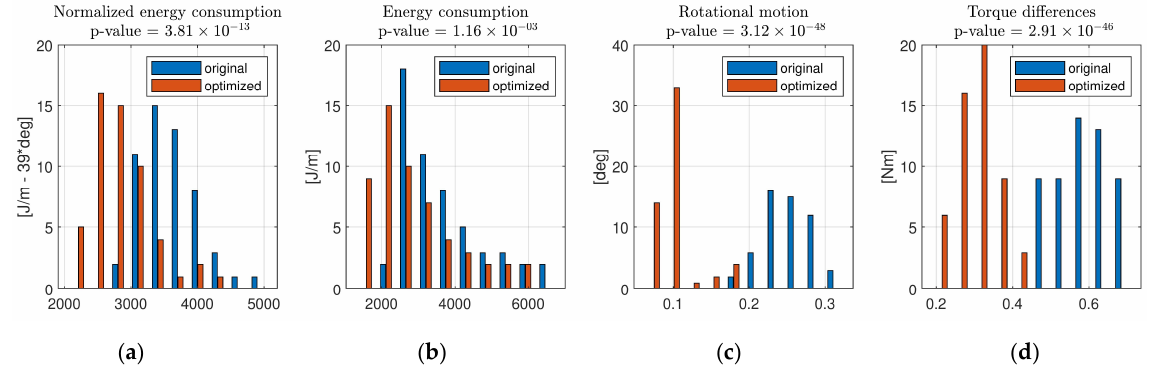
Figure 9. Distribution comparison of the objective values between the original and optimized structure. ( a ) Normalized energy consumption. ( b ) Energy consumption. ( c ) Torque differences. ( d ) Rotational motion.